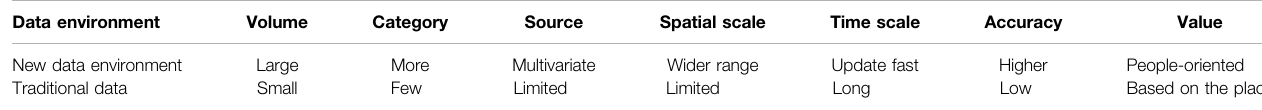
TABLE 2 | Comparison between the new urban spatial data environment and traditional data